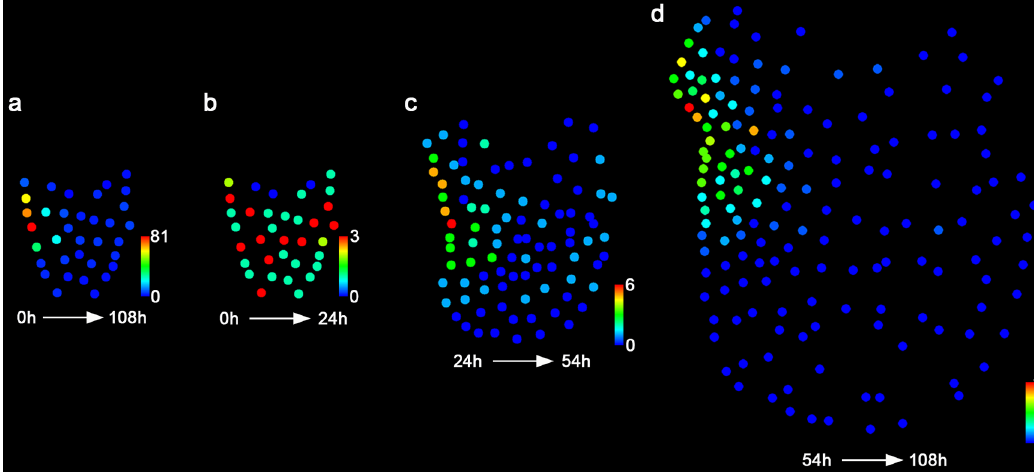
Fig. 5 Quanti fi cation of cell division events in the Ceratopteris gametophyte. a – d Quanti fi cation of cell division events at different developmental stages, including the time frames of 0 – 108 h ( a ), 0 – 24 h ( b ), 24 – 54 h ( c ), and 54 – 108 h ( d ). Each colored dot represents the detected individual nuclei of the gametophyte shown in Fig. 2. The quanti fi ed cell division events are mapped to the images from the fi rst time points of the indicated intervals. Colors indicate the total number of cell division events for each cell lineage during the indicated time frames, with the scale from blue (0) to red (81) in a ; from blue (0) to red (3) in b ; from blue (0) to red (6) in c ; and from blue (0) to red (12) in d . Three independent samples were analyzed, showing similar results (Fig. 5; Supplementary Figs. 8 and